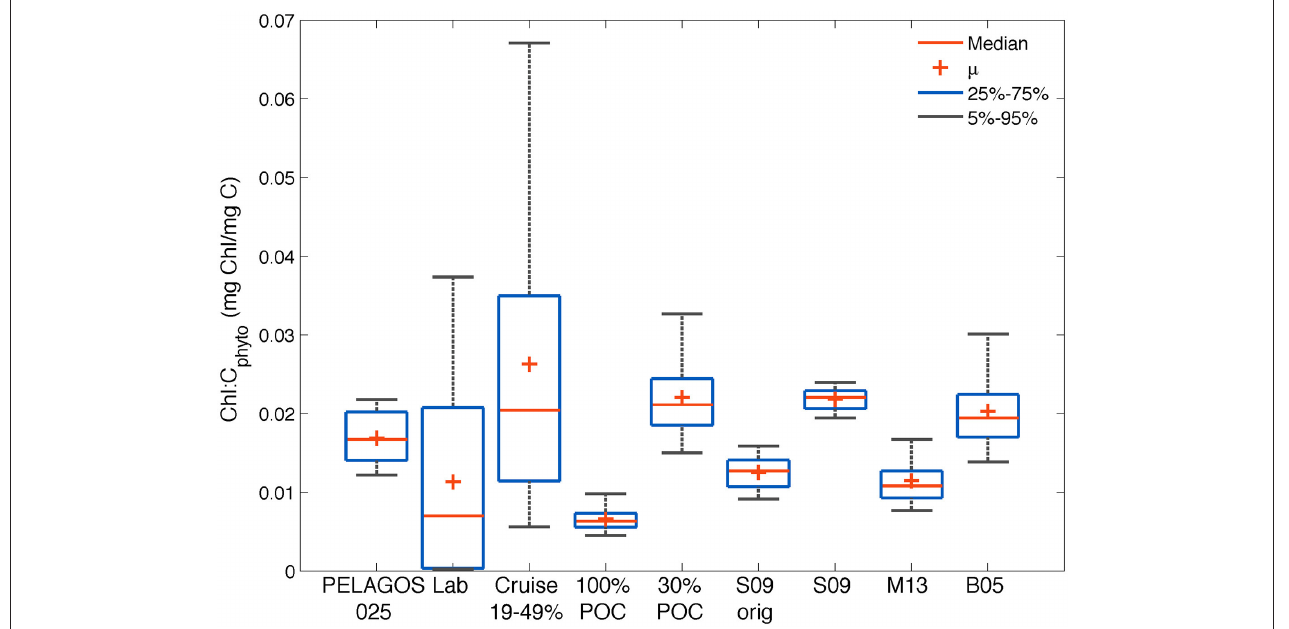
FIGURE 8 | Comparison of the distribution of chl-a:Cphyto ratios derived from (1) the four glider estimates in the SAZ (30%POC, S09, M13 and B05); (2) the PELAGOS025 model for the glider transect (0–10 m); (3) a collation of laboratory culture experiments from the literature [Lab: n = 127, Supplementary Table 1 ( Montagnes et al., 1994; Sunda and Huntsman, 1995; Llewellyn and Gibb, 2000)]; (4) from Southern Ocean cruise data (Cruise, 0–20 m) assuming a phytoplankton carbon fraction of 19, 30, and 49%; (5) minimum possible ratios derived from the glider data if all POC